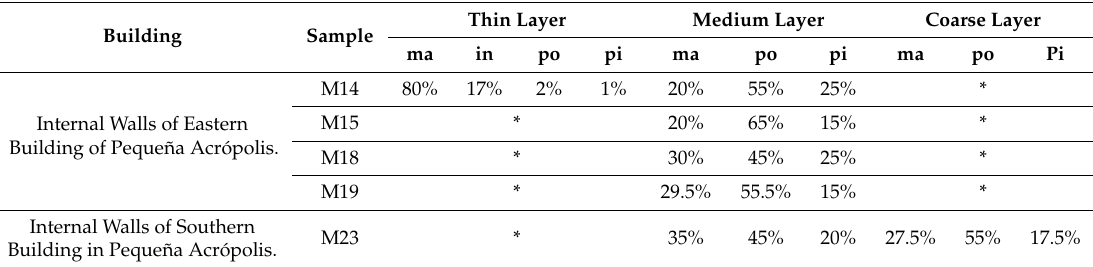
Table 5. Proportions in the Type 2 plasters; the data are based on the percentage of matrix (ma), inclusions (in) and pores (po) in each layer. * represents a layer that could not be sampled either because it was not observed, because the layers that were above were too hard and well preserved or because the layer was so powdery that it was not possible to sample